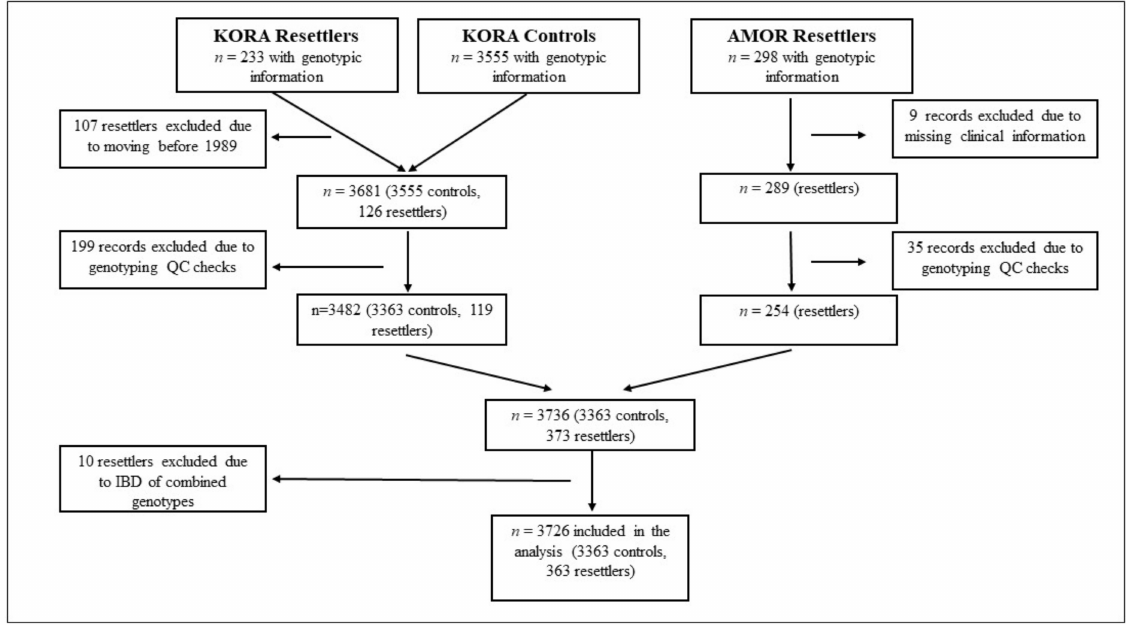
Figure 1. STROBE flow